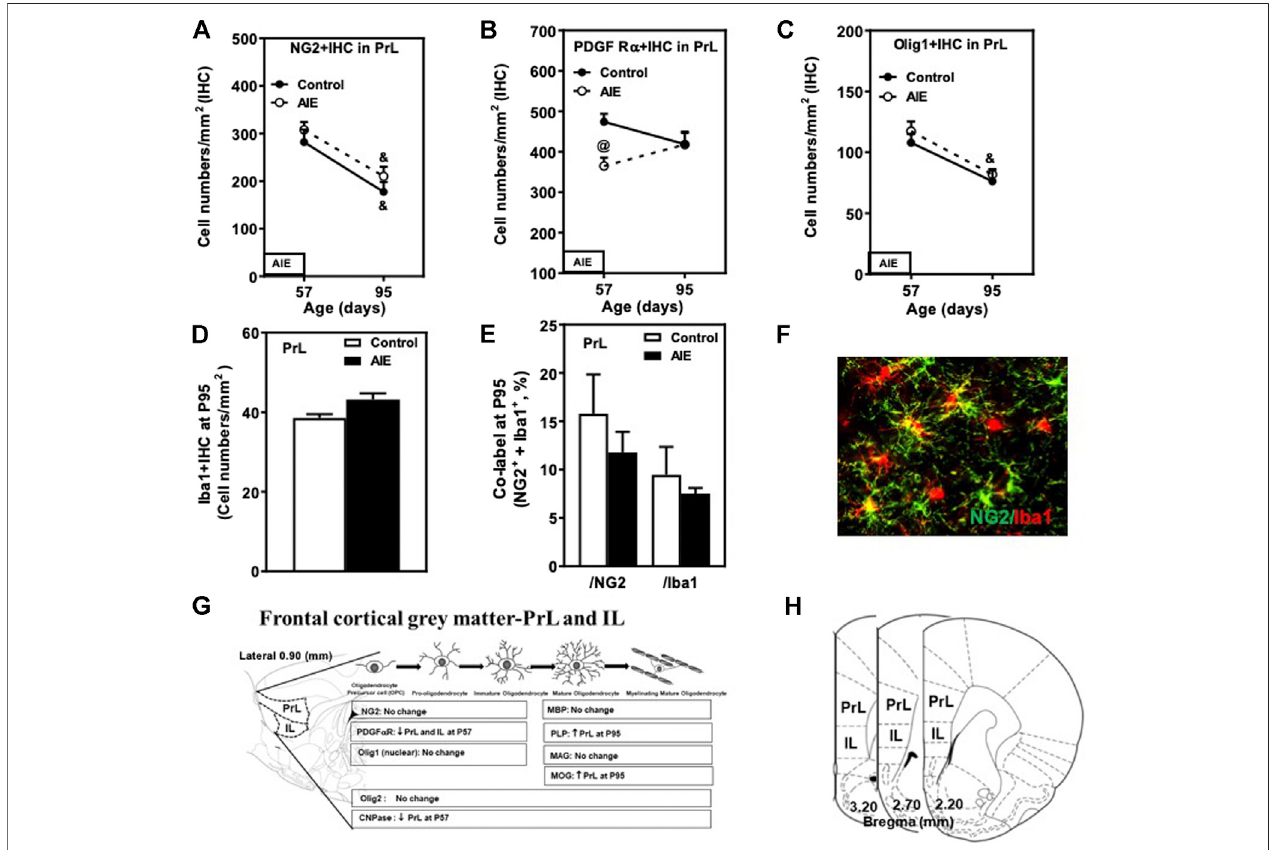
FIGURE 4 | Effects of age and AIE on NG2 and OPC markers in the frontal gray matter, prelimbic cortex (PrL). (A) NG2+IHC expression showed maturational decline in both controls (48%) and the AIE group (36%). (B) AIE exposure decreased 34% of PDGF R α +IHC at P57. (C) Olig1+IHC expression showed maturational declineinbothcontrols(31%)andtheAIEgroup(30%). (D) AIEexposureresultedinan16%increaseinIba1+IHCexpression( p (cid:1) 0.056)atP95comparedwithcontrols. (E) AIE exposure did not affect co-localization of NG2+/Iba1+ cells in either NG2+ cells or Iba1+ cells at P95 compared with controls. 50 – 100 NG2+ or Iba1+ positivecellspersamplewereanalyzedforco-localizationwithIba1+orNG2+cells.Thepercentage ofco-localizationinNG2+orIba1+positivecellswascalculated. (F) Photomicrographs of co-labeled images in the PrL, NG2+ (green) and Iba1+ (red), image 20 × . (G) Schematic diagram representing the developmental stages of oligodendrogenesis in the frontal cortical gray matter-prelimbic (PrL) and infralimbic (IL) cortex. The speci fi c markers that are expressed in distinct stages are indicated below,Arrow “ ↑ ” representsincrease; “ ↓ ” decease; “ atP57 ” and “ atP95 ” representsatpostnataldays57and95respectively; “ nochange ” meansthatAIEdidnotaffect the markers ’ expression. Rat atlas panel of the left side reprinted from Paxinos and Watson (2014). (H) The frontal cortical gray matter and the prelimbic (PrL) and infralimbic (IL) cortex of male rat brain were used by the histological method. The positive cells of oligodendrocyte progenitor and myelin markers of shaded areas were counted.Rat atlas panelswere reprinted from Paxinos and Watson (2014).Datawereexpressed asthe numbers ofNG2+ (A) ,PDGF R α + (B) , Olig1+ (C) and Iba1+IHC (D) positive cells. Each point is mean ± SEM per mm 2 ; n (cid:1) 7 –